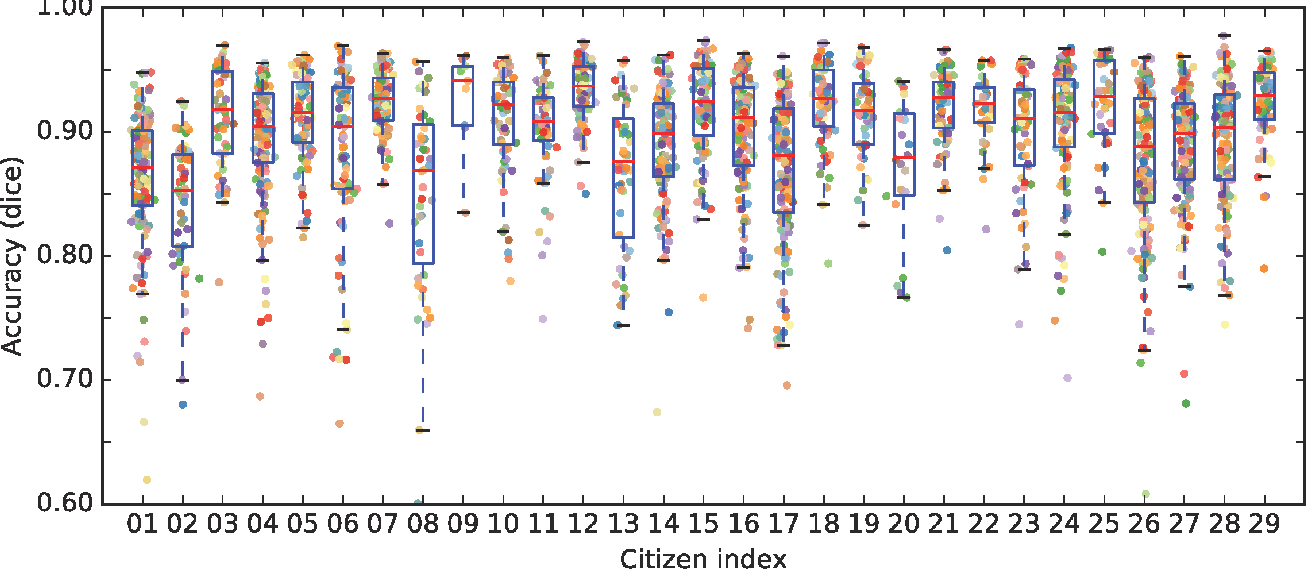
Fig 5. Segmentation accuracy by citizen. The plots show the accuracy (Dice coefficient) for each citizen, compared to the expert consensus (a score of 1 indicates exact overlap with the experts). Each dot represents a single image. Box plots show the median (red line), the lower to upper quartiles (blue boxes) and range (dotted blue